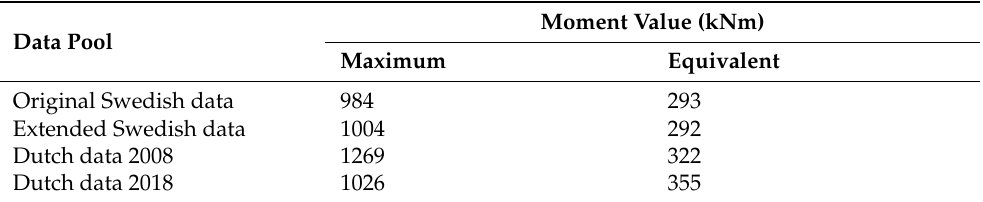
Table 3. Bending moment response of the passage of the different traffic data pools over the midspan of a 10 m simply supported